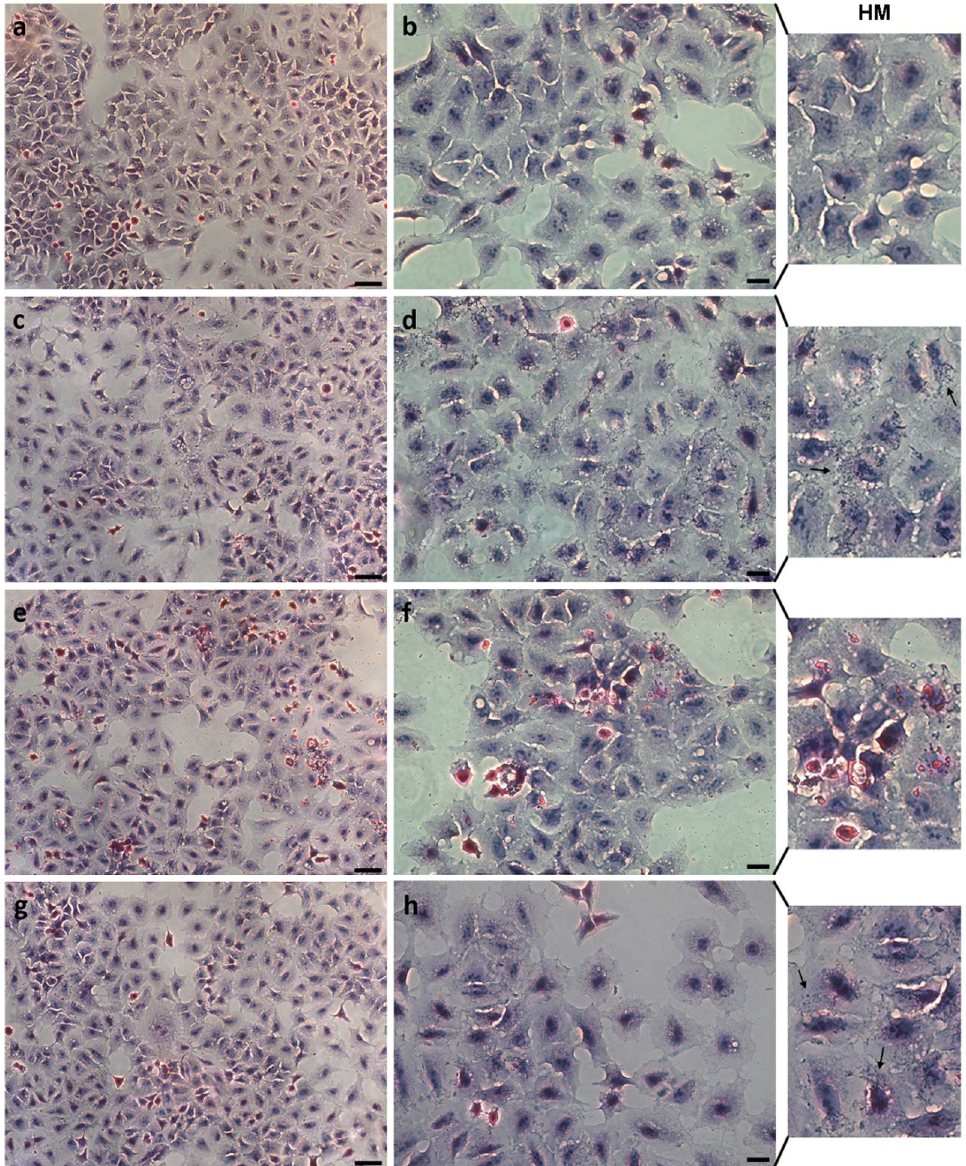
Figure 8. Morphology of cells after exposure to 75 μg TiO 2 /mL of TiO 2 :SiO 2 NPs 1:1 ( c , d ), 1:3 ( e , f ), 3:1 ( g , h ). Control cells are shown in ( a , b ). Cells were fixed and stained with Hematoxylin/Eosin. Scale bars: 50 μm (a,c,e,g); 20 μm (b,d,f,h). HM: high magnification of (b,d,f,h). Black arrows: nanoparticles interacting with cells.